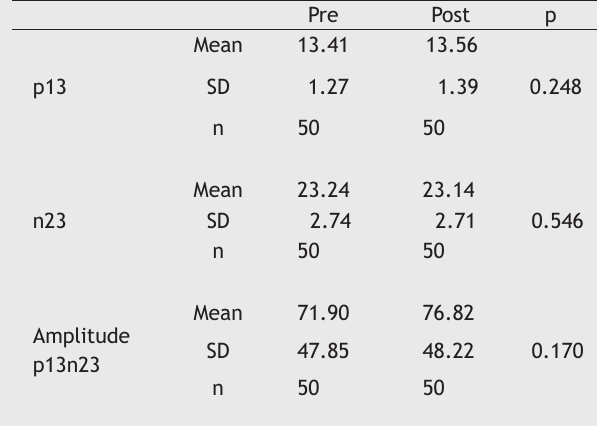
Table 3 Comparison between